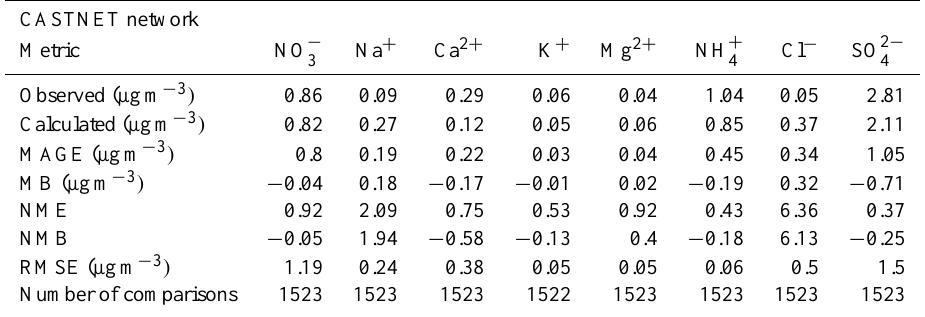
Table 3. Statistical evaluation of EMAC-simulated aerosol concentrations against monthly average observations from North America during 2005–2008.